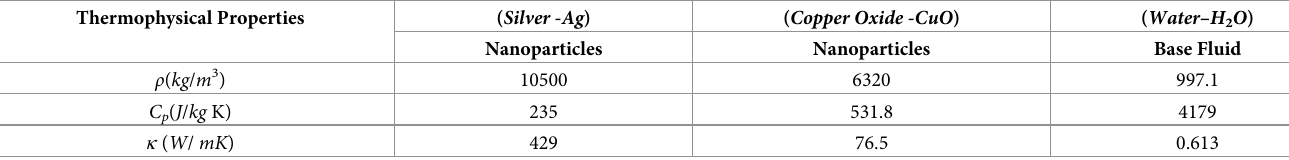
Table 3. Numerical values of nanoparticles and base fluid for thermophysical properties [39]. Thermophysical Properties